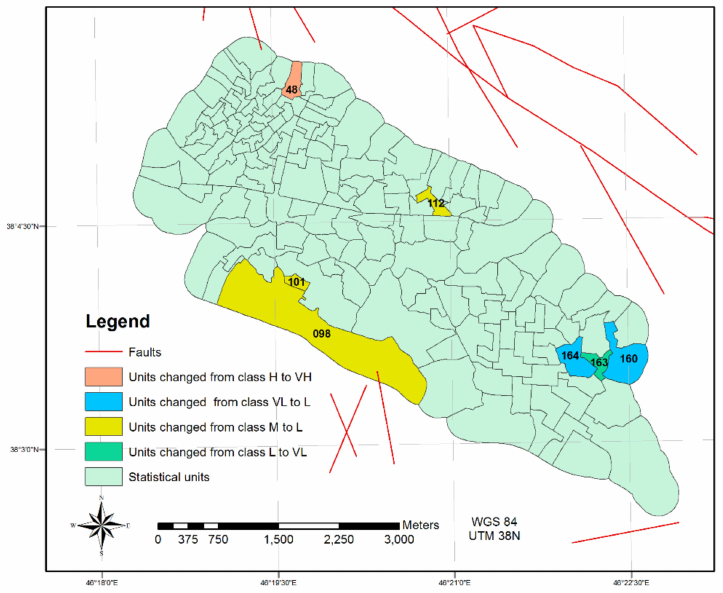
Figure 7. The statistical units which their vulnerability classes were